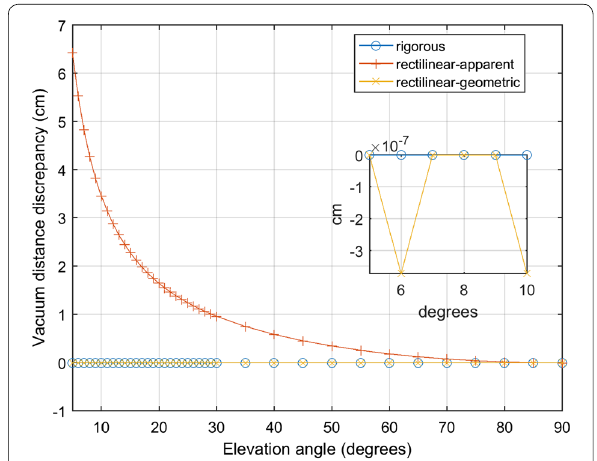
Fig. 2 Vacuum distance discrepancy as a function of satellite elevation angle (for a fixed 10‑m reflector